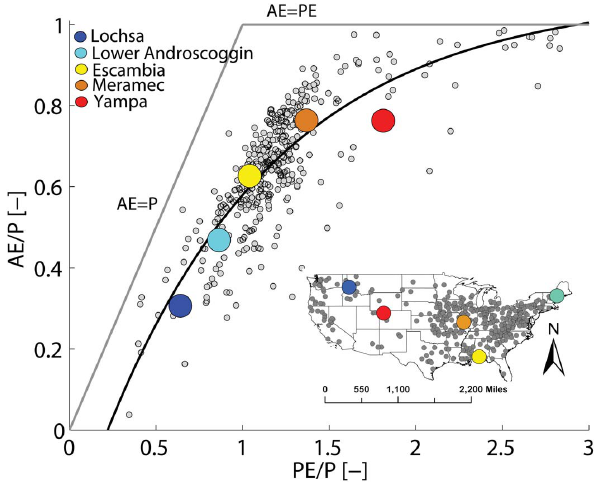
Fig. 2. The Budyo curve with the five study watersheds (394 water- sheds are shown as grey dots) highlighted. The black curve shown is a fitted Schreiber model. AE, PE and P are the long term actual evapotranspiration, potential evapotranspiration, and precipitation respectively. AE/ P is equal to 1-runoff ratio and PE/ P is the aridity